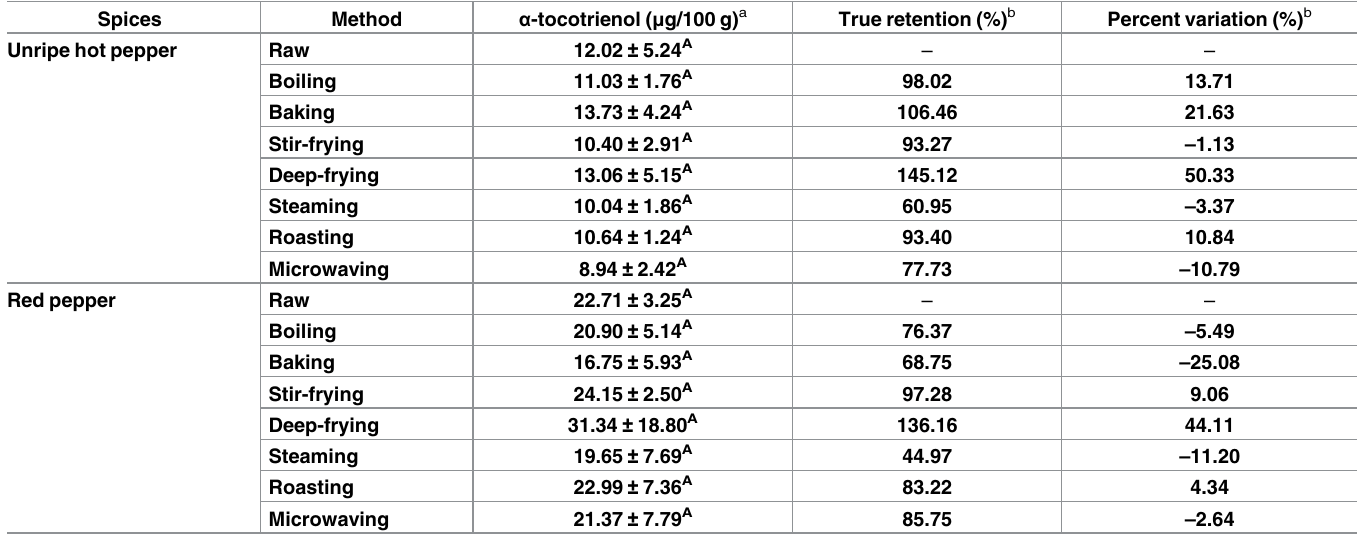
Table 3. Effect of different cooking methods on the content, true retention and percent variation of α -tocotrienol in unripe hot pepper and red pepper.